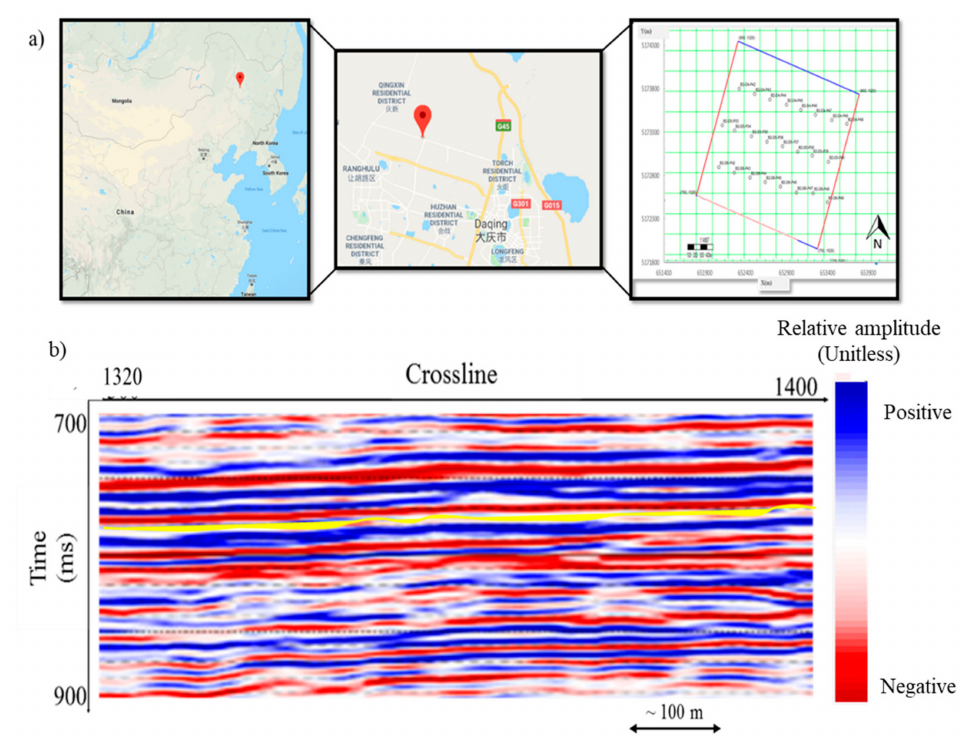
Figure 1. ( a ) Location of the seismic survey. Black dots represent the relative location of 24 wells. ( b ) Inline of spectrally broadened volume. The yellow horizon represents the top of the reservoir